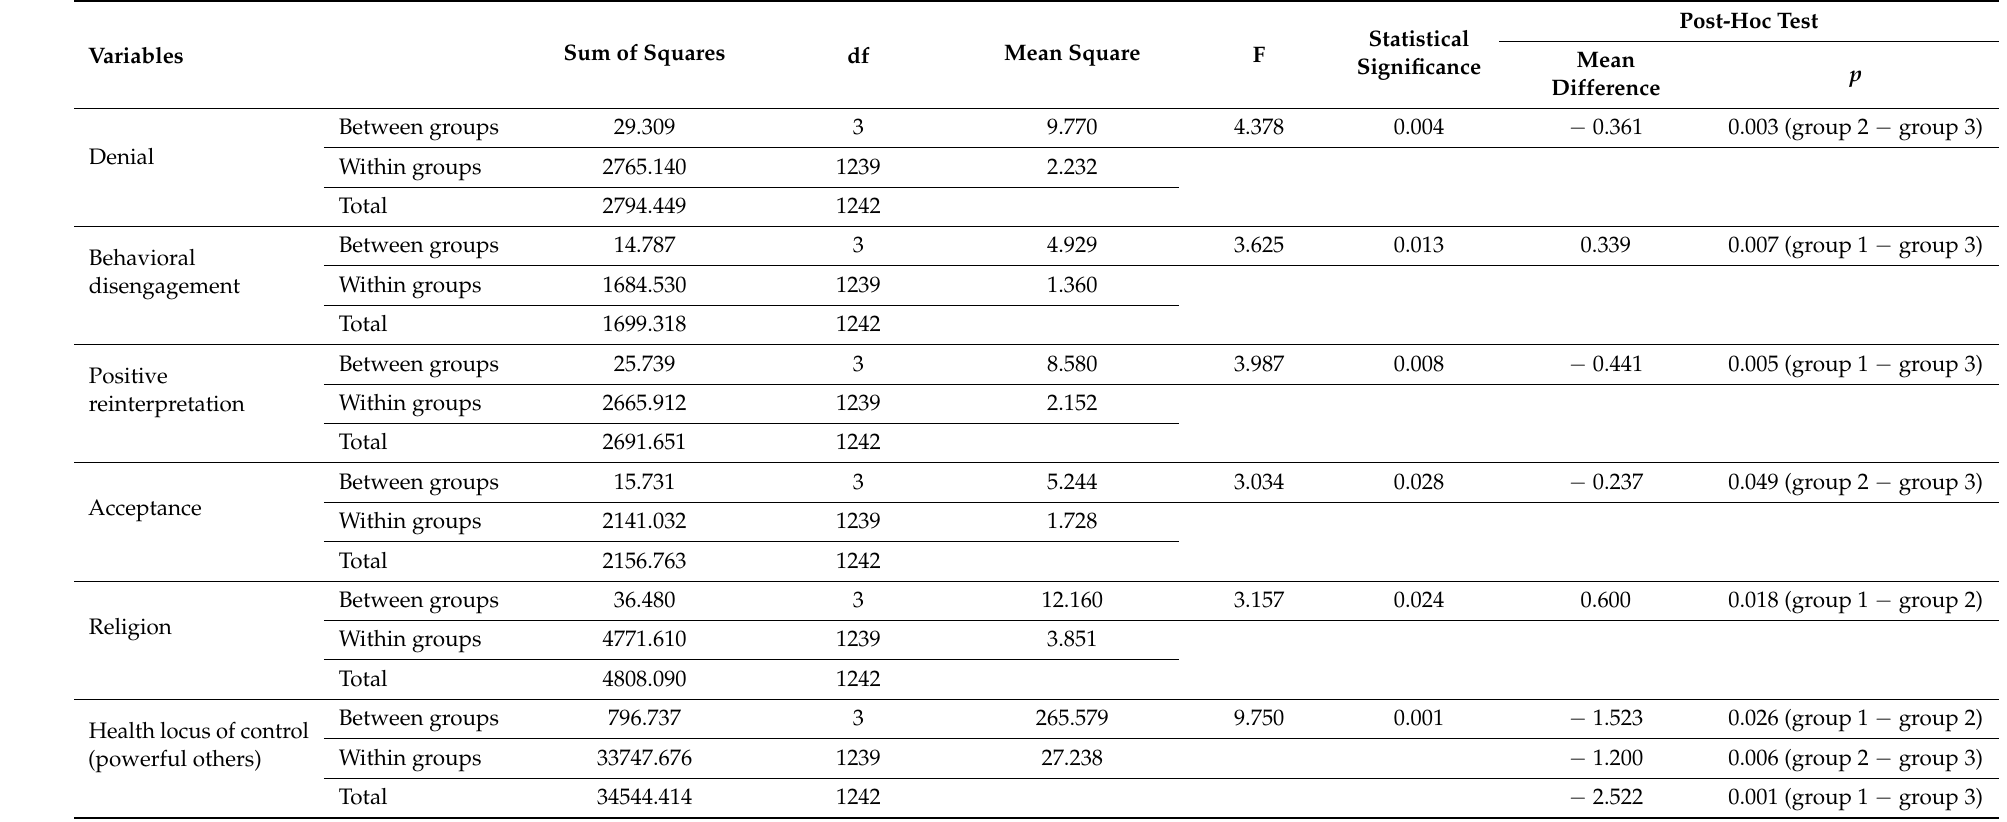
Table 3. Statistical differences between the study groups